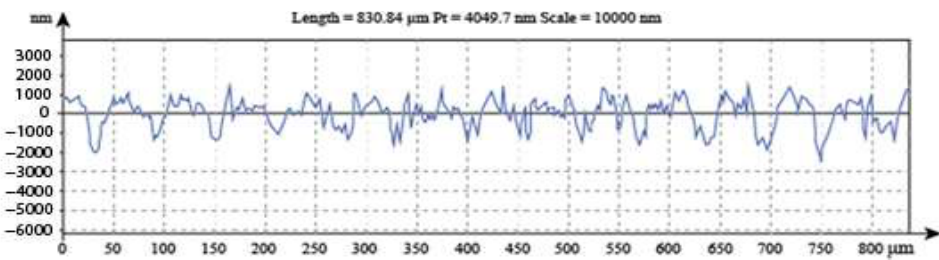
Figure 9. Surface roughness profile for the mild steel sample.